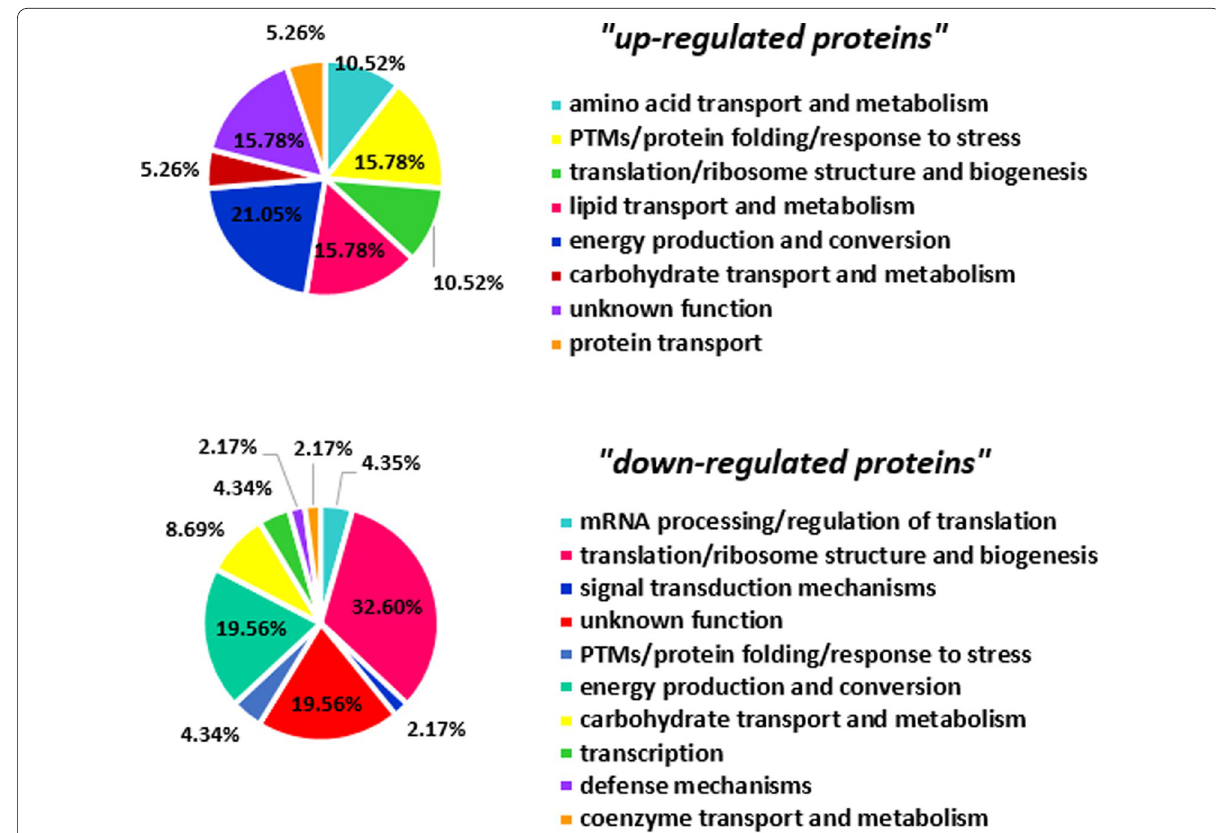
Fig. 2 COG (clusters of orthologous groups) function classification coverage of the protein sequence. A total of 8 and 10 groups of all up‑regulated & down‑regulated of differentially expressed proteins were clustered by orthologous groups, respectively. PTM: post‑translational